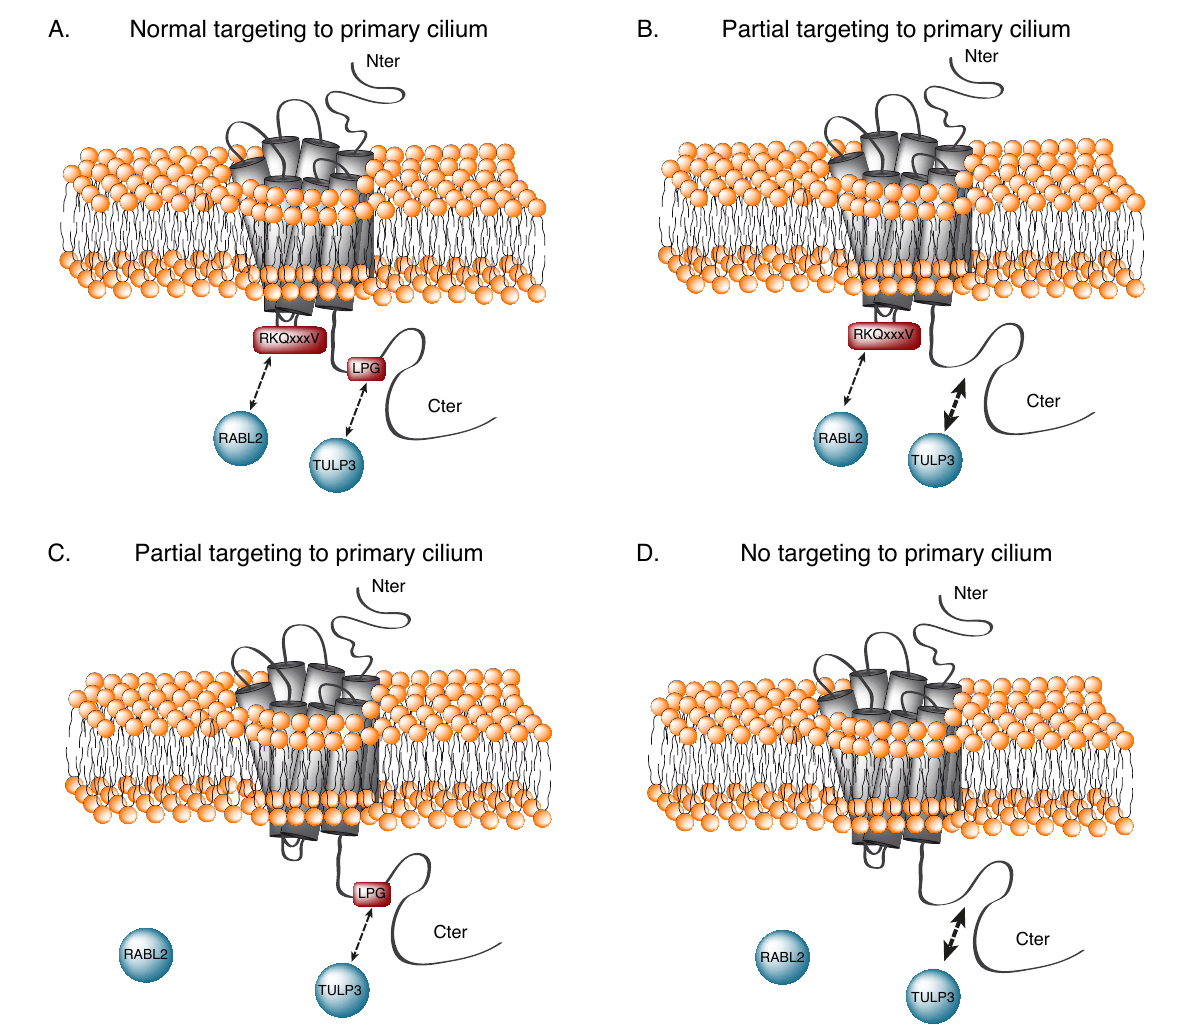
Figure 2. The 5-HT 6 R possesses 2 cilia-targeting sequences (CTSs). When present, CTS1 (on the ic3 loop) interacts with the RABL2 GTPase, whereas CTS2 (on the C-terminal domain) interacts with TULP3. Both CTSs are required for normal cilia targeting ( A ). Cilia targeting is only partial when CTS2 is mutated, but paradoxically, interaction with TULP3 is increased rather than lost ( B ). When CTS1 is mutated, interaction with RABL2 is lost, and cilia targeting is diminished ( C ). Finally, mutating both CTSs results in a complete loss of ciliary localization of the receptor ( D